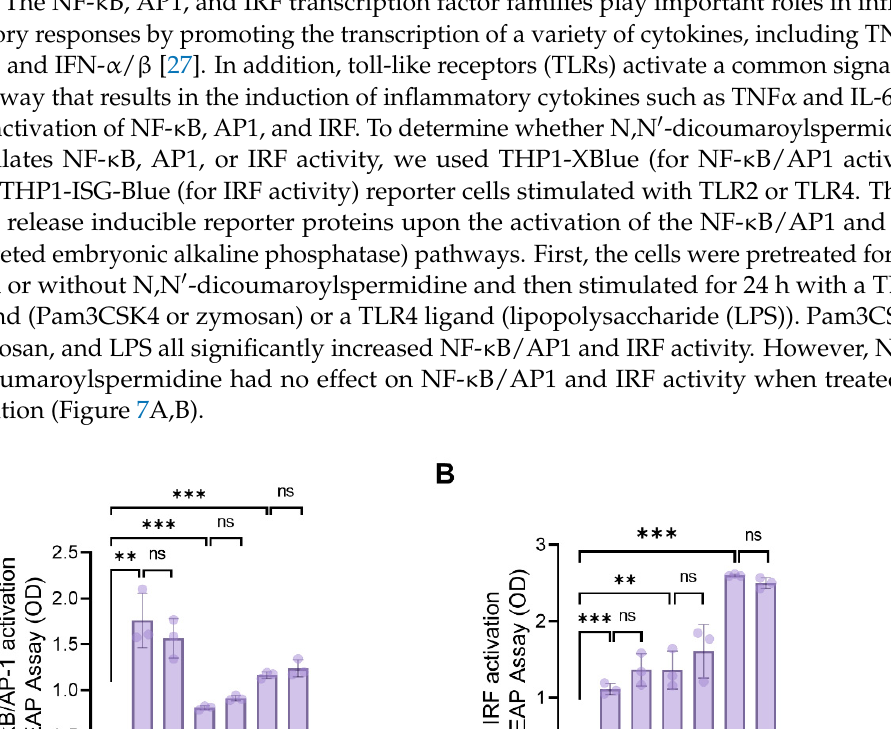
Figure 6. Cytotoxic effects of compounds isolated from the L. erythrorhizon cold and reflux EtOH extracts against THP1 and RBL-2H3 cells. ( A , B ) Viability of ( A ) THP1 and ( B ) RBL-2H3 cells, as assessed in an MTT assay after 24 h exposure to the indicated extracts (50 μ g/mL) or isolated compounds (50 μ M). LE_R, 95% ethanol reflux extraction at 70 °C; LE_C, 95% ethanol extraction at room temperature: (1) erythrin A, (2) erythrin B, (3) N,N ′ -dicoumaroylspermidine, (4) room temperature: (1) erythrin A, (2) erythrin B, (3) N,N (cid:48) -dicoumaroylspermidine, (4) anhy- anhydroalkannin, droalkannin, (5) deoxyshikonin, (6) shikonin, (7) isobutyrylshikonin, (8) β -hydroxyisovalerylshikonin, (9) acetylshikonin, (10) α -methylbutyrylshikonin, and (11) isovalerylshikonin. Data are expressed as isovalerylshikonin. Data are expressed as the mean ± SD. ** p < 0.01 and *** p < 0.001 versus the the mean ± SD. ** p < 0.01 and *** p < 0.001 versus the control group. Experiments were independently control group. Experiments were independently repeated three times. repeated three times.